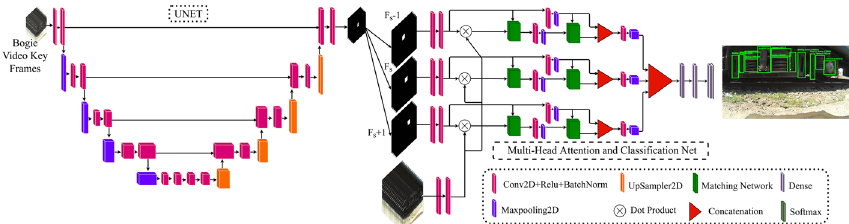
Fig. 2 Deep bogie part inspector architecture with two models: the first model is UNet used for segmentation of bogie parts, and the second is the multi-head attention-based classification